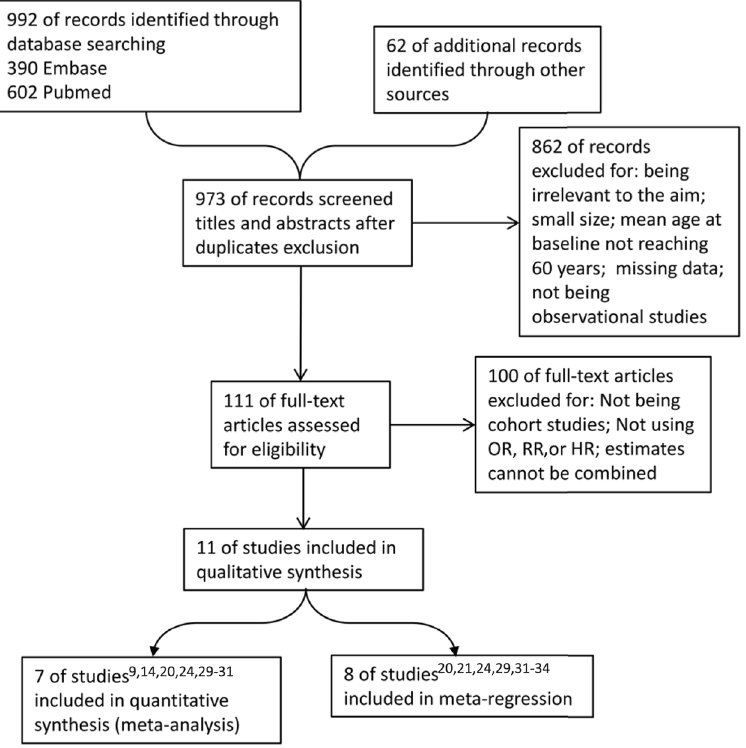
Figure 1. PRISMA flow chart of study selection. PRISMA = Preferred Reporting Items for Systematic Reviews and Meta-analyses. OR = odds ratio, RR = relative risk, HR = hazard